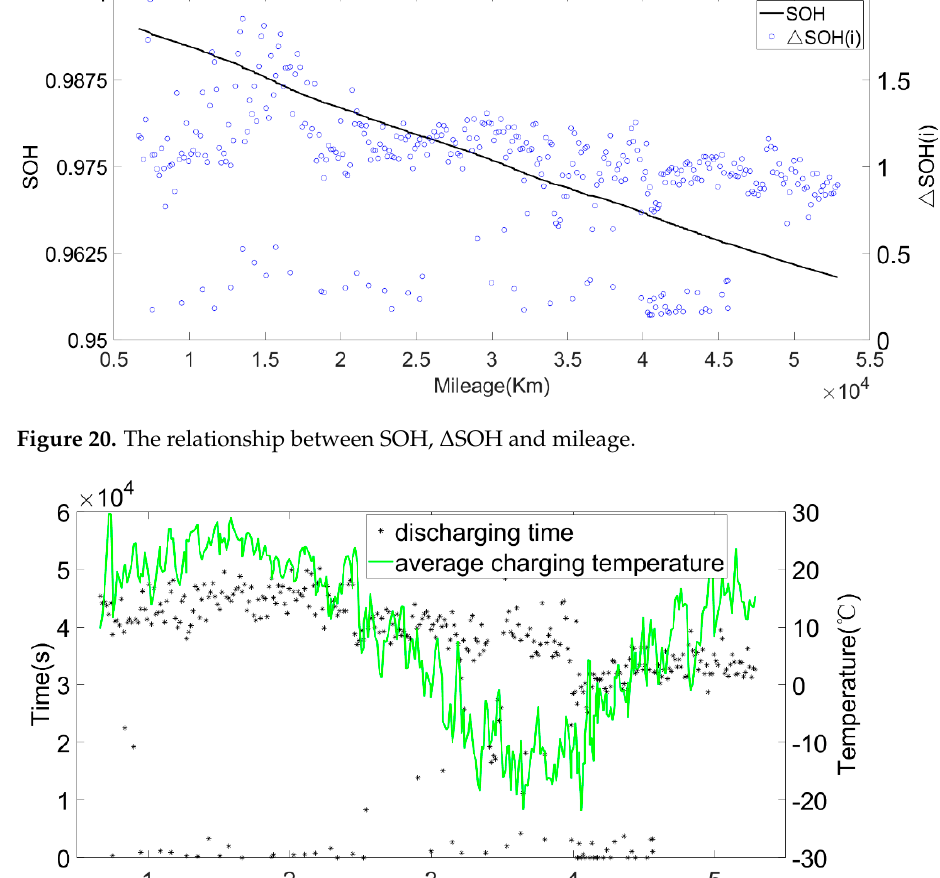
15 of 23 Figure 19. The relationship between the charging current, average charging temperature and mile- age. 4.2. SOH Δ